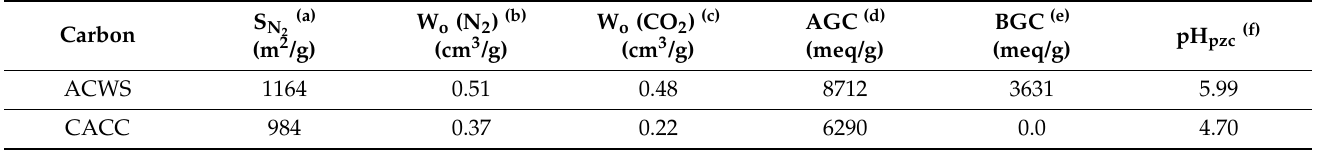
Table 3. Textural and chemical characteristics of activated carbons ACWS and